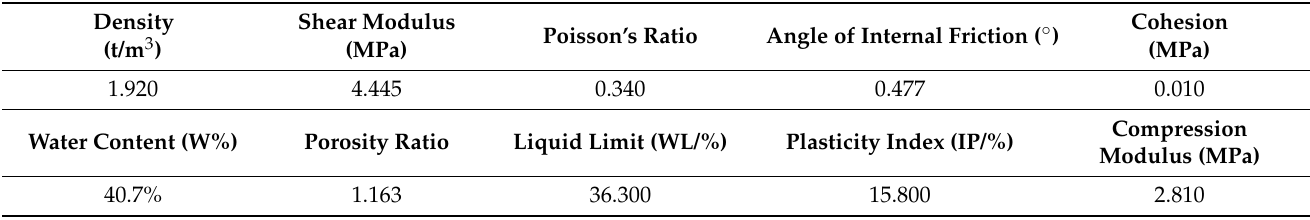
Figure 5. The simplified geometric model and the finite element model of the Hall anchor. ( a ) The simplified geometric model of the Hall anchor, and ( b ) The finite element model. Table 5. The parameters of the sandy clay in Zhoushan